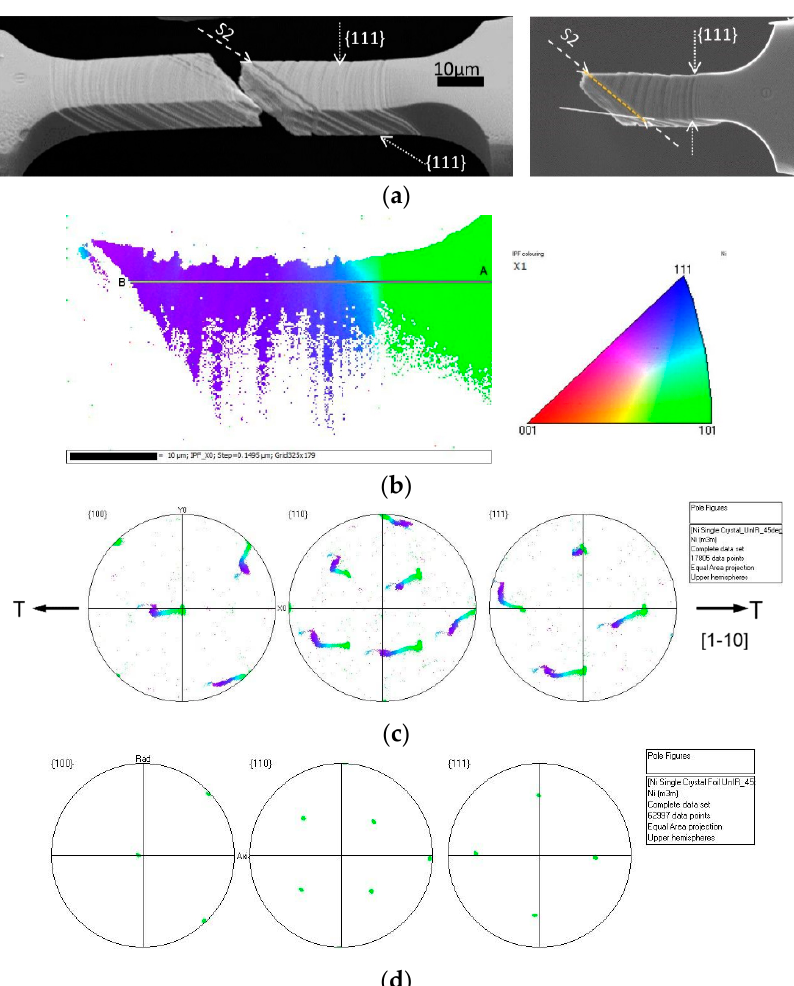
Figure 4. ( a ) An SEM image of the [110]-orientated single crystal nickel after tensile deformation; ( b ) an EBSD inverse pole figure map of the right half of the fractured sample in ( a , c ) for the pole figures of single crystal nickel after tensile deformation; ( d ) the pole figures of the [110]-oriented sample before testing [47].